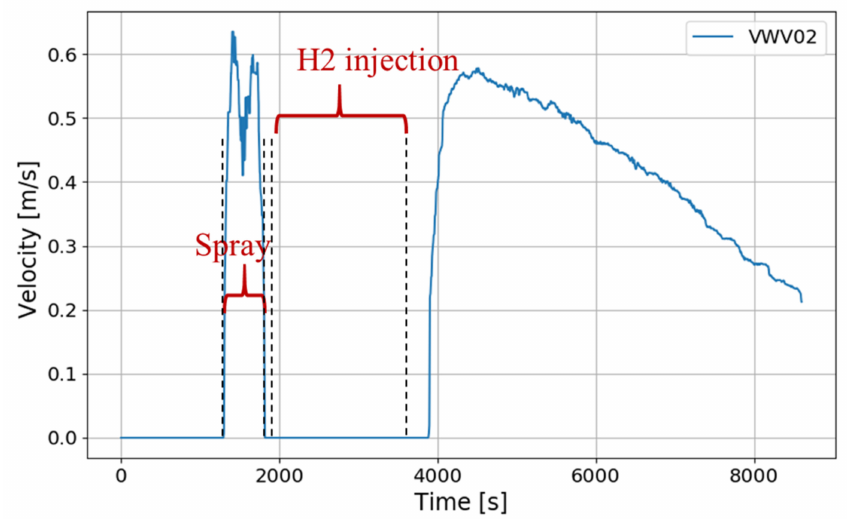
Figure 15. Time variation in the gas velocity measured at the PAR inlet during the SSP3